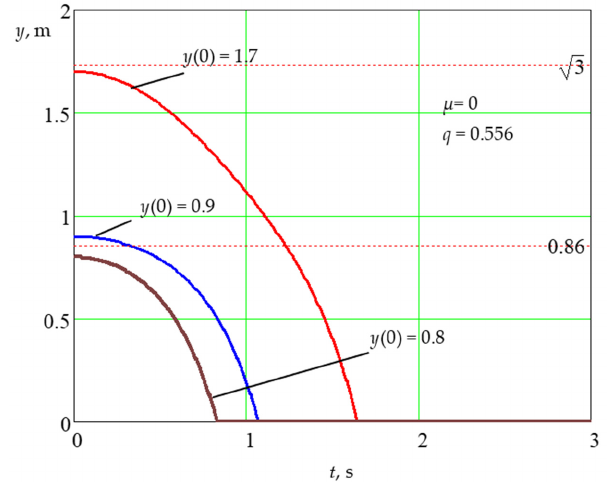
Figure 11. Movement of a frictionless system from different starting points with a rigidity of the thread insufficient for the occurrence of free vibrations.